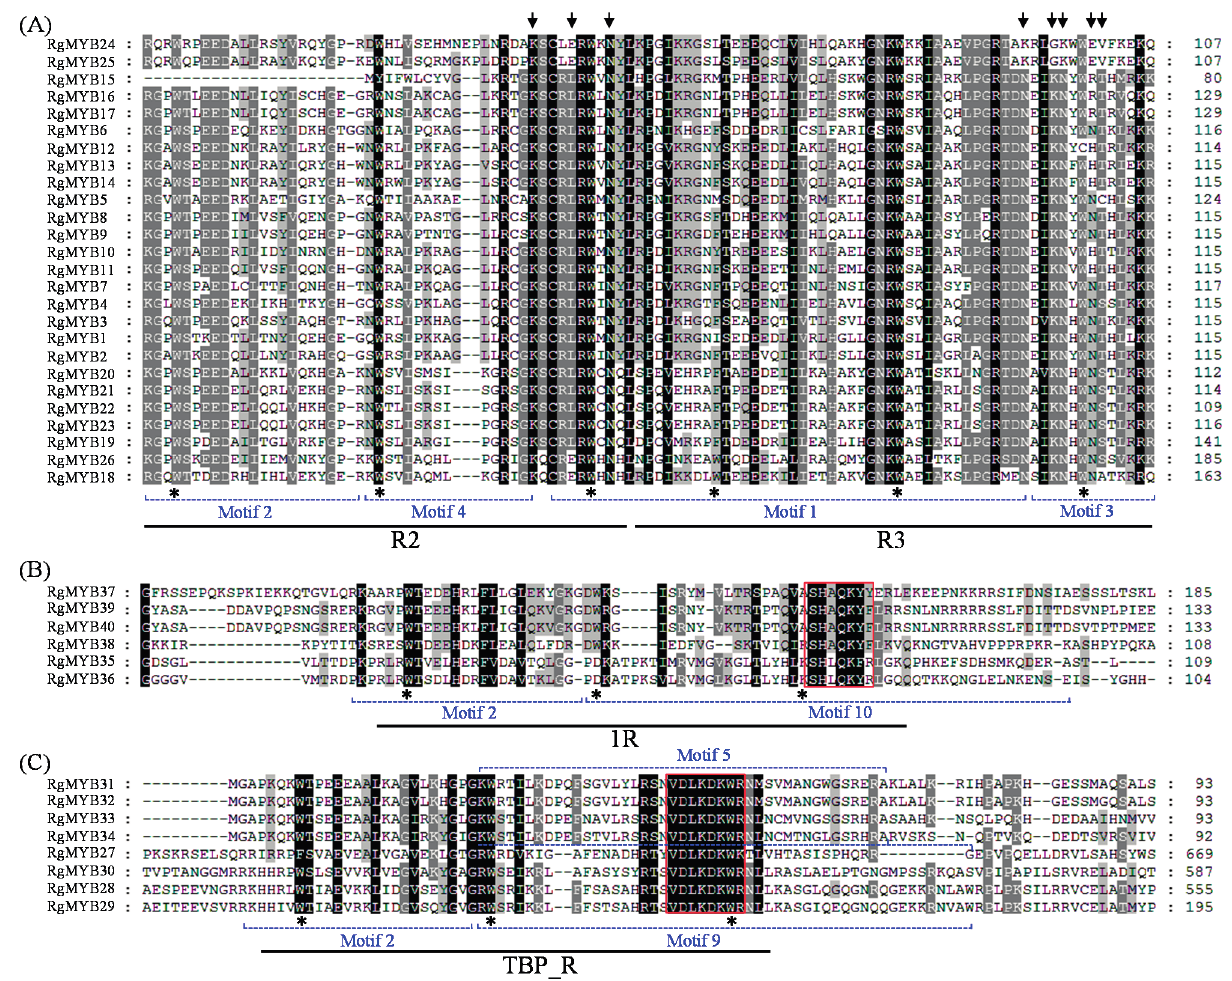
Figure 2. Highly conserved amino acid residues are present among the R2R3 ( A ), 1R ( B ) and TBP_R ( C ) domains of the R. glutinosa MYBs. The three regularly spaced Trp residues present in each repeat of the MYBs are labeled with asterisks. The amino acid sequences are aligned, and gaps (dots) have been introduced to maximize the alignment. The shading of the alignment presents identical residues in black, conserved residues in dark gray, and similar residues in light gray. The positions corresponding to base-contacting residues of the human MYBs are marked with arrows. The highly conserved SHAQKYF motifs in 1R and VDLKDKWR motif in TBP_R are boxed. Position of motif 2 plus motif 4 and part of motif 1 in Figure 1 relative to the R2 domain, motif 1 plus motif 3 relative to the R3 domain, motif 2 plus motif 10 relative to 1 R domain, motif 2 plus motif 5 or motif 9 relative to TBP_R